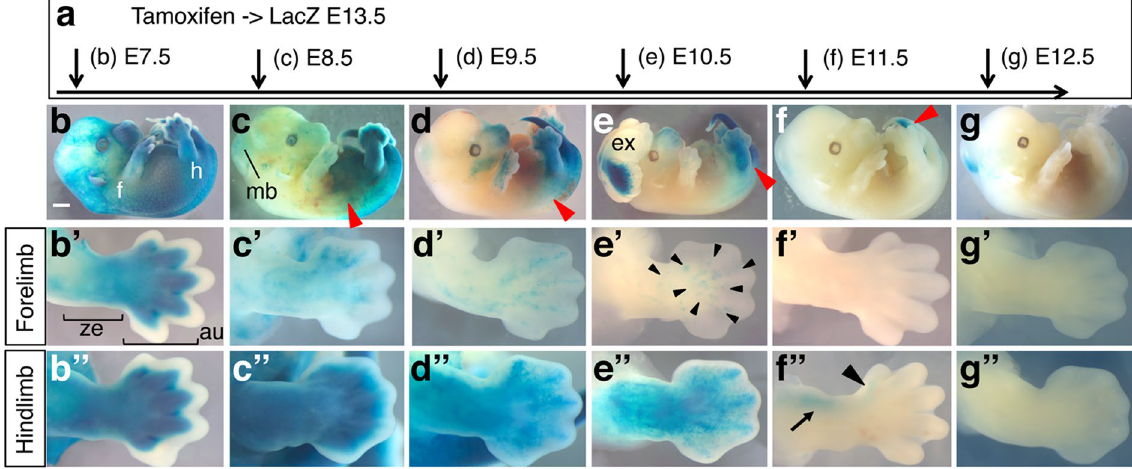
Figure 2. Sall4 lineage contribution to E13.5 embryos. Schematic of tamoxifen injections at different time points of embryonic development. The stages of tamoxifen injection are indicated. ( b – g ) Whole mount images of LacZ-stained E13.5 embryos. Red arrowheads in c-g point to the anterior margin of LacZ staining. The embryo in panel e exhibits exencephaly. (b’–g’) Dorsal views of forelimbs of embryos shown in ( b – g ). Black arrowheads in e ’ point to sparsely stained LacZ-positive areas. In panel b’, the autopod region (au) and the zeugopod region (ze) are indicated by brackets. (b”–g”) Dorsal views of hindlimbs of embryos shown in ( b – g ). Black arrowhead and arrow in f” point to LacZ-positive anterior digit and anterior zeugopod, respectively. Anterior is to the top and posterior is to the bottom in b’–g’ and b”–g”. Abbreviations: au: autopod region, fl: forelimbs, hl: hindlimbs, ze: zeugopod region. Scale bar in panel b: 1 mm. Panels b to g are in the same